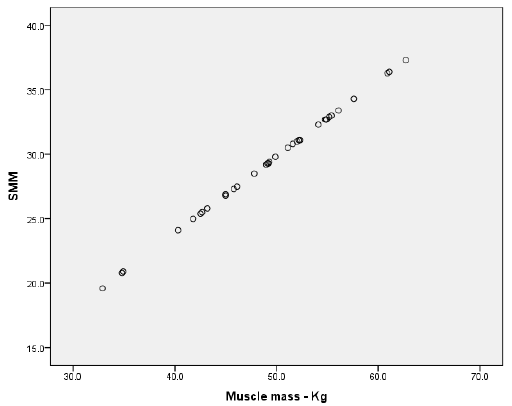
Figure 9. Correlation between SMM and muscle mass (kg) for the group of boys with MID.